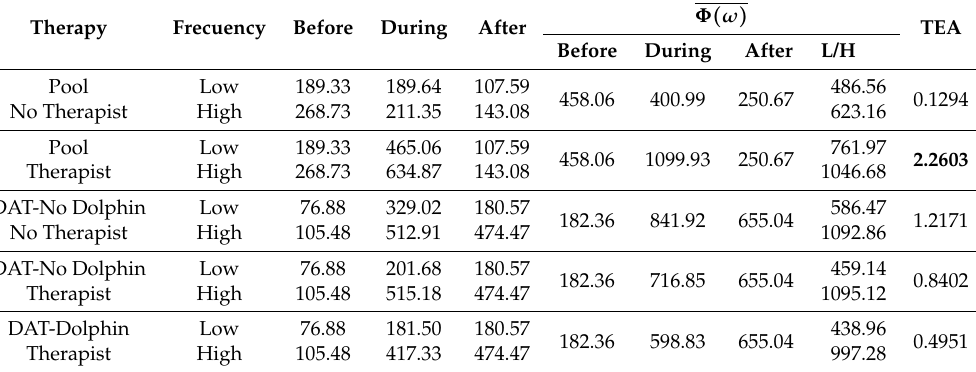
Table 2. Results of the Patient 2 (Intervention), On 01/25/2020, bold type indicates best TEA (dB).